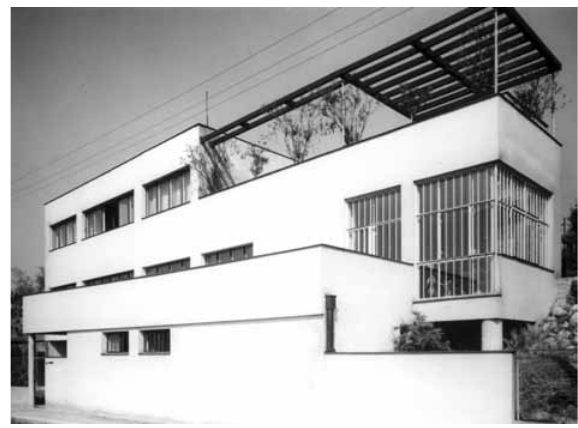
fig. 11. j. Gočár, Villa Kytlica in the Baba district, 1932–1933